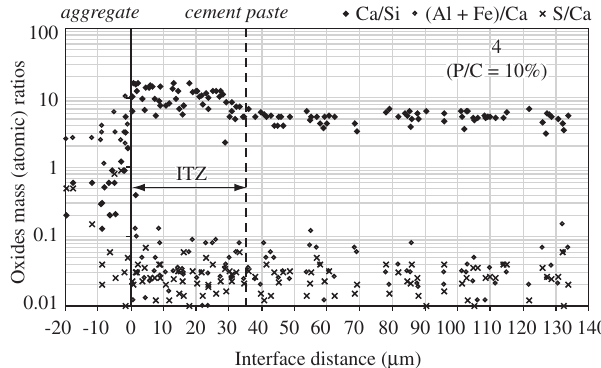
Figure 8. Interfacial transition zone thickness of the